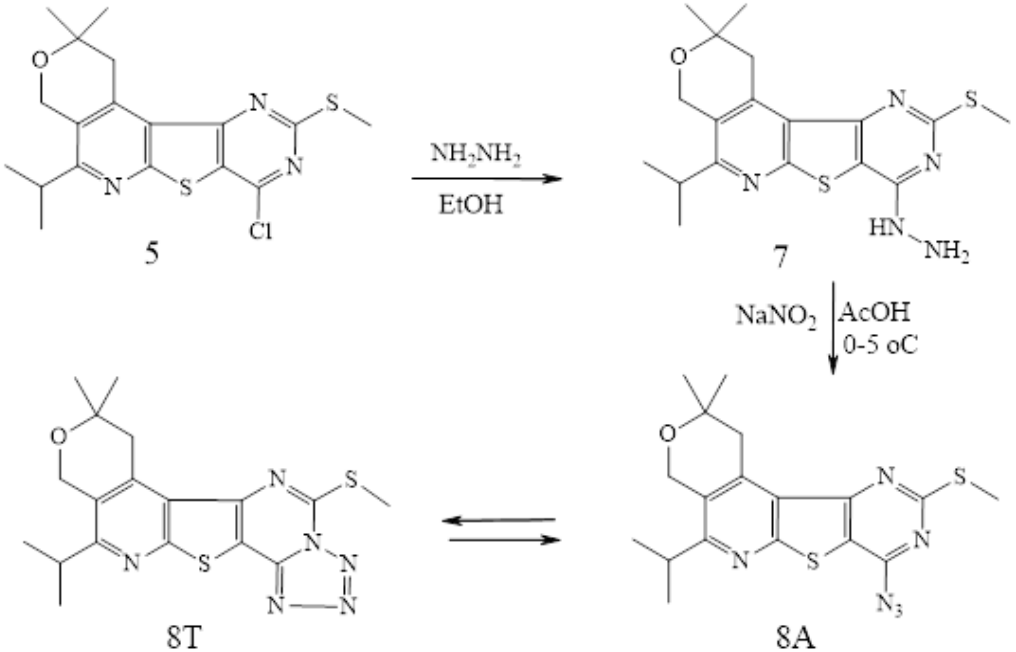
Figure 2 - Synthesis of 8-azidothieno[3,2- d ]pyrimidine/thieno[2,3- e ]tetrazolo[1,5- c ]pyrimidine 8